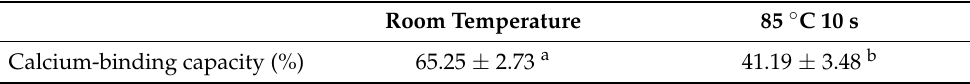
Table 2. The calcium-binding capacity of EWP-Ca and sterilization treatment